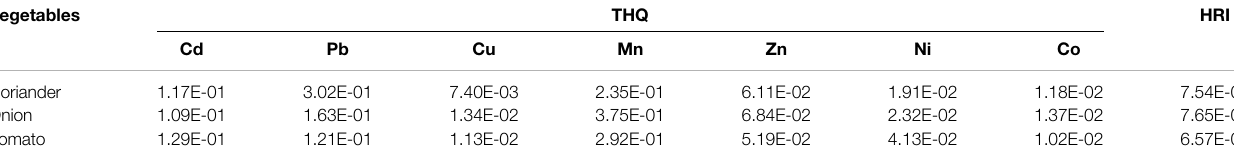
TABLE 6 | Target Hazard Quotient (THQ) of heavy metals for various vegetable crops. Vegetables